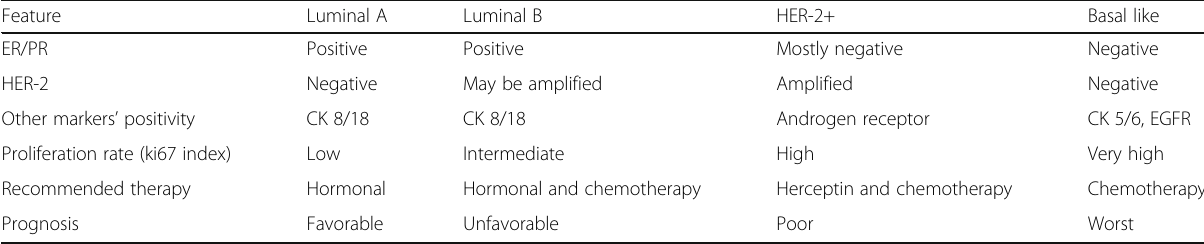
Table 1 Molecular classification of breast carcinoma